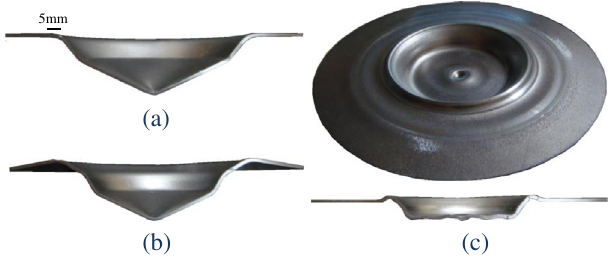
Figure 4. Cross-sectional shapes of cups for s 1 = 22 mm, s 2 = 19 mm and h = 10 mm: (a) 1st stage, (b) 2nd stage and (c) 3rd stage.